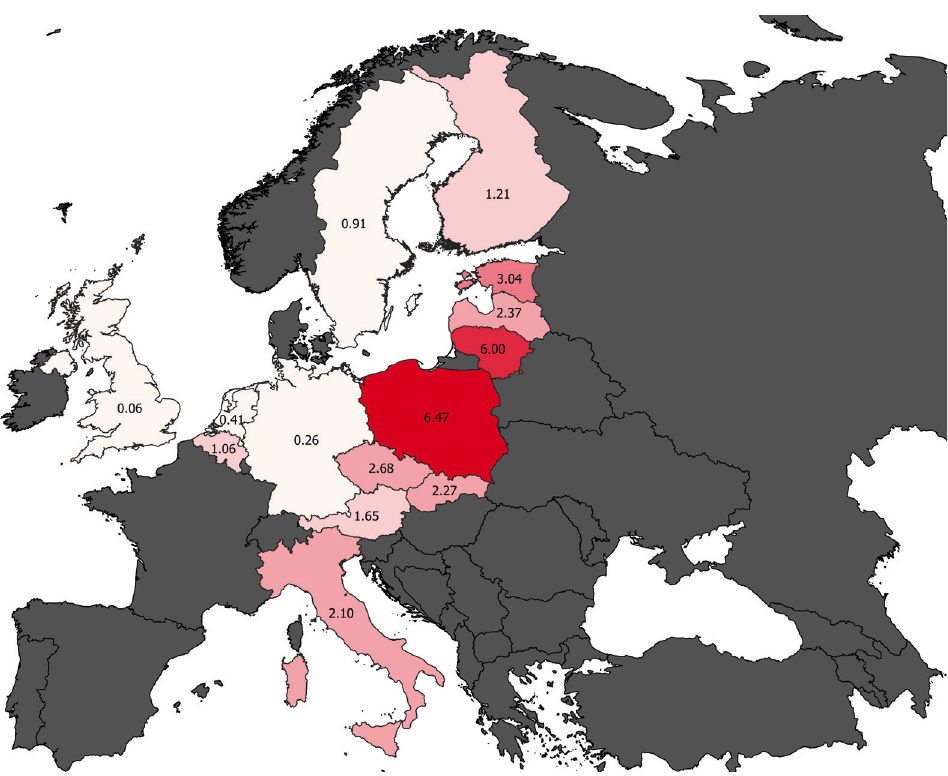
Figure 2. Geographical distribution of road traffic death rates at pedestrian